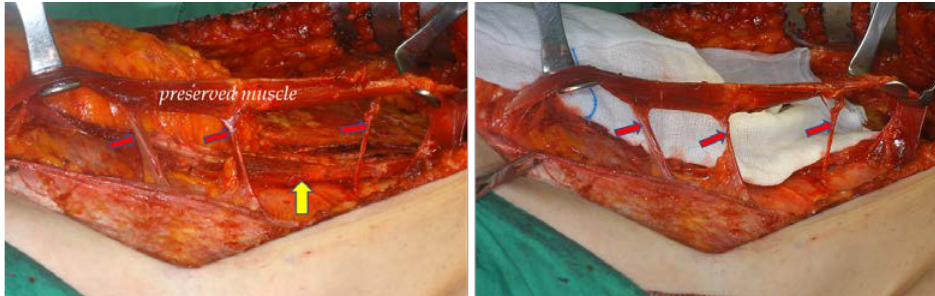
Figure 3. Preserved rectus muscle with innervated intercostal nerve (red arrows). The yellow arrow indicates the rectus muscle that is used as the pedicle, and the muscle held by the Army-Navy retractor is the preserved rectus muscle.